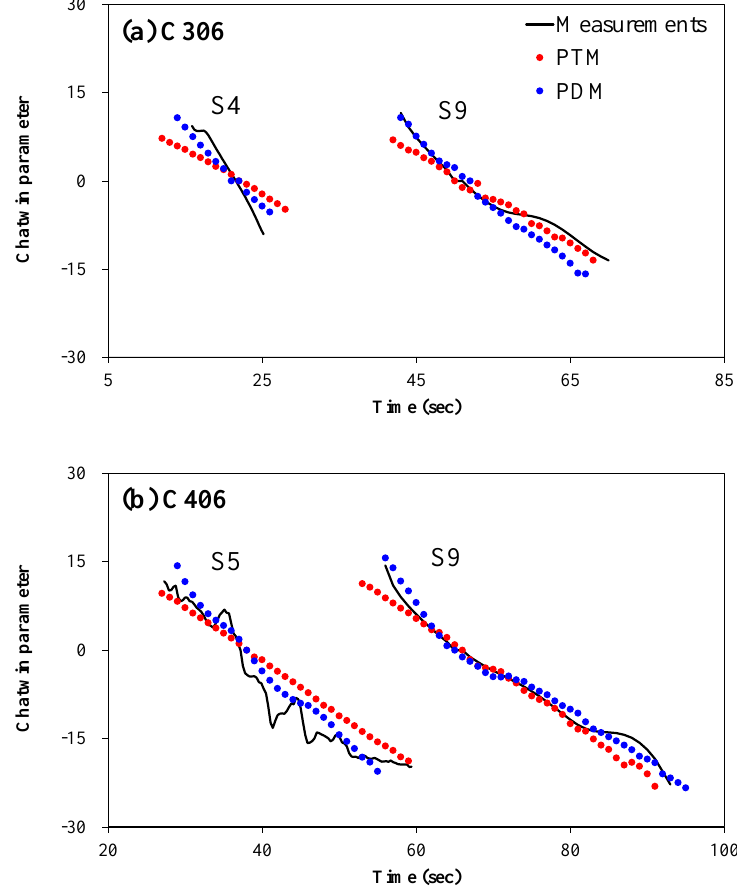
Figure 9. Comparisons of Chatwin’s parameter of C – t curves obtained in the channel bends. The time variation of Chatwin’s parameter indicates the temporal change of the concentration curves, in which the rising and falling parts of the concentration curves represent positive and